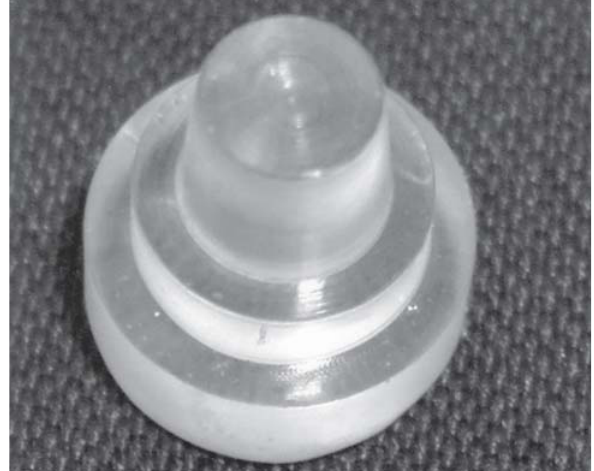
FIGURE 1- Epoxy resin die